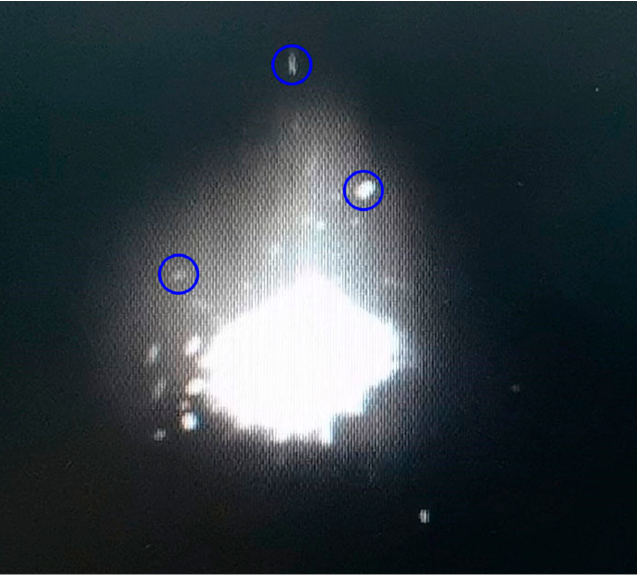
Figure 2. Phenomenon of the charge being blown up by the gas flow at the center of the furnace throat.